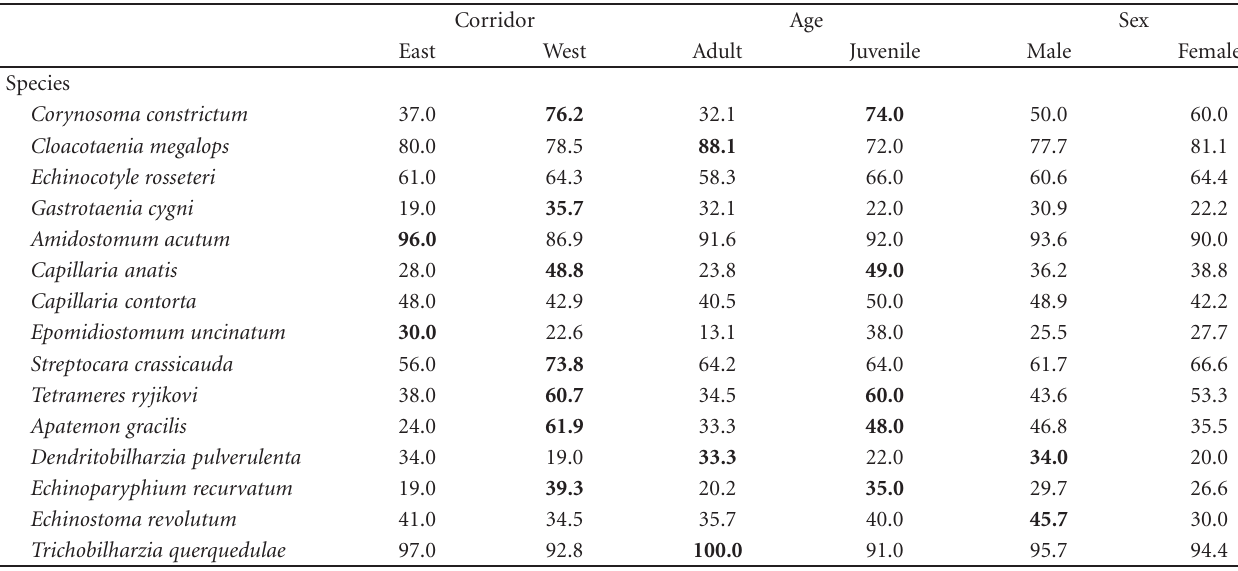
Table 2: Prevalence of the 15 common/intermediatespecies by migratory corridor, hostage, and host sex from 184 blue-winged teal collected in Florida, Louisiana, and Texas from 21 September through 30 October